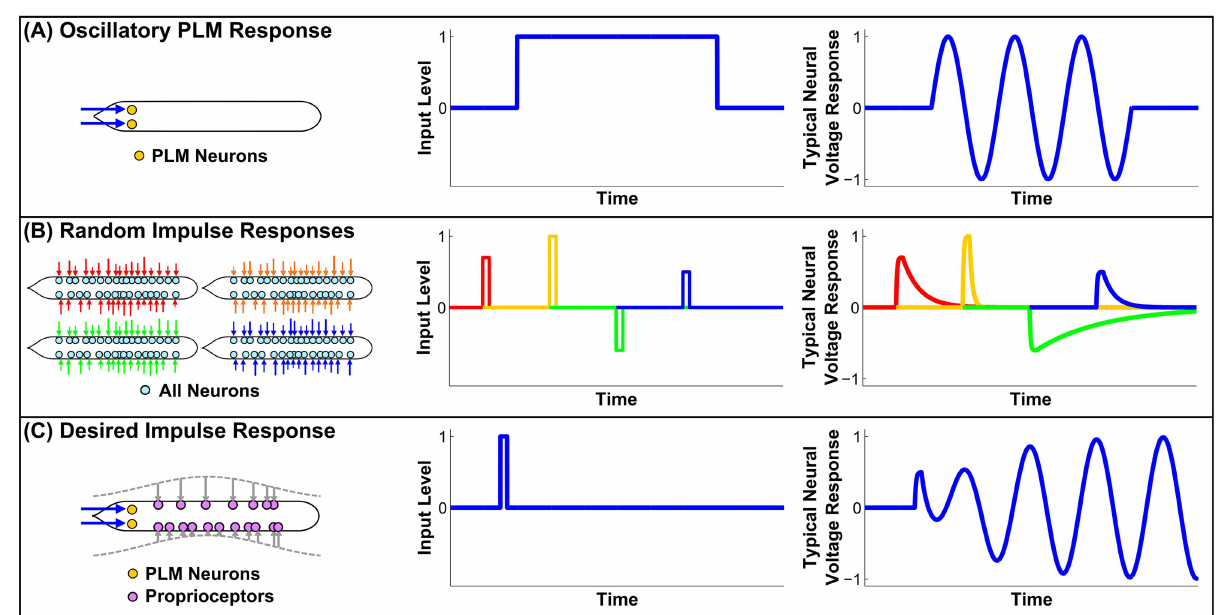
Fig 1. (A) Illustration of the oscillatoryresponse as demonstrated in [11]. Unrealistically, the system requiresconstant stimulationor it will collapseinto a fixed point. This is consistant with evidencethat proprioceptive feedbackis necessary for sustaineddynamic responses to external input. (B) Illustration of the responseto momentary random stimuli. After any stimulus, the system will decay back to the fixed point, albeit at different timescales. We will use this to probe the dynamicalstructure of the fixed point. (C) Illustration of a potentially more realistic response.We seek a mechanismfor proprioceptive feedbackwhich produces sustainedresponses to momentarystimuli. We will investigatethe consistency of our model with such a